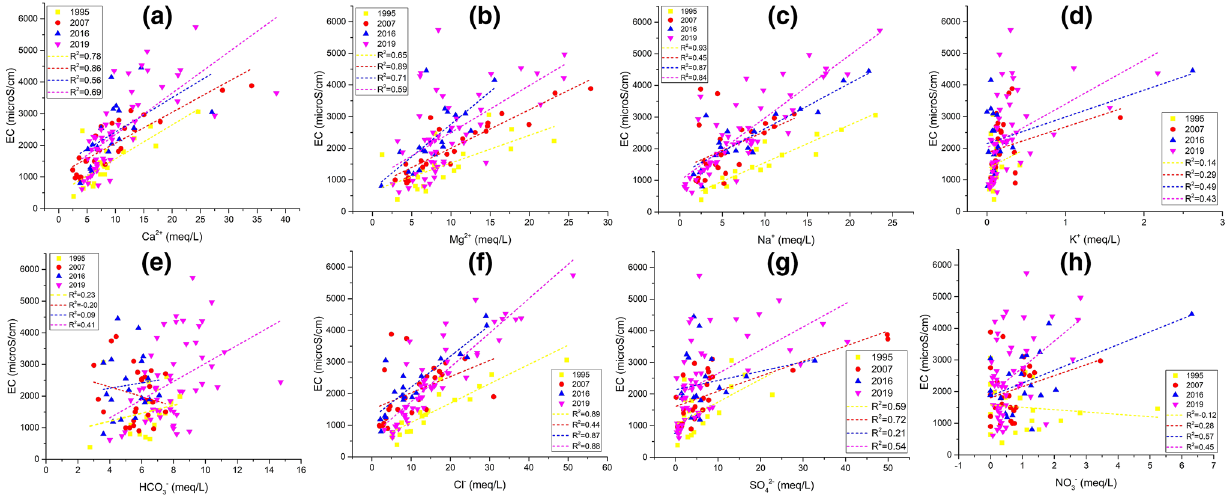
Fig. 5 Bivariate plots of electrical conductivity (EC) plotted against chemical constituents of